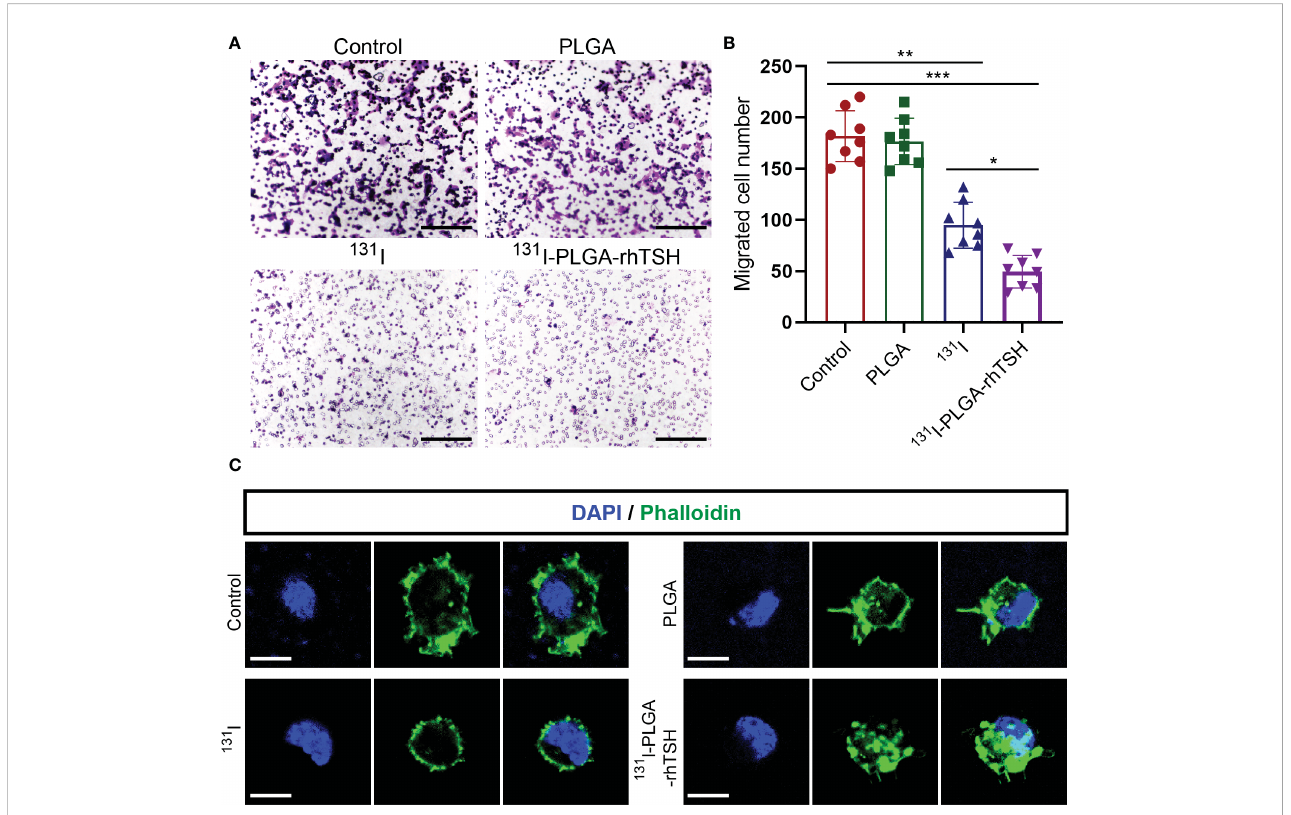
FIGURE 7 The application of 131 I-PLGA-rhTSH inhibited FTC-133 cells mobilization through reducing F-actin assembling. (A) The typical transwell images illustrating the mobilization ability of FTC-133 cells per group. Scale bars: 50 m m. (B) Bar graph summarizing the migrated cell number from upper to lower chamber from (A) . n = 8 per group; * p < 0.05, ** p < 0.01, *** p < 0.001; one-way ANOVA, followed by Tukey ’ s post hoc test. (C) The representative phalloidin staining images presenting the status of F-actin assembly in each group. Scale bars: 5 m